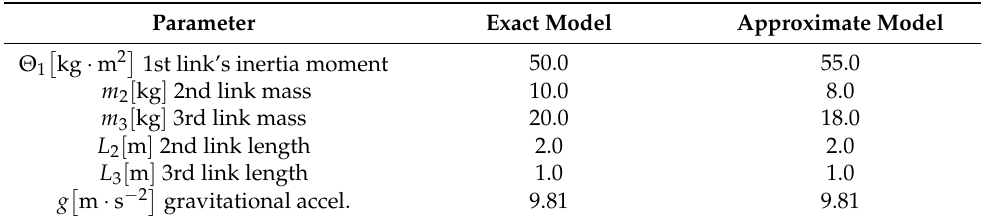
Table 1. The robot model parameters in Equations (6)–(8). Parameter Exact Model Approximate